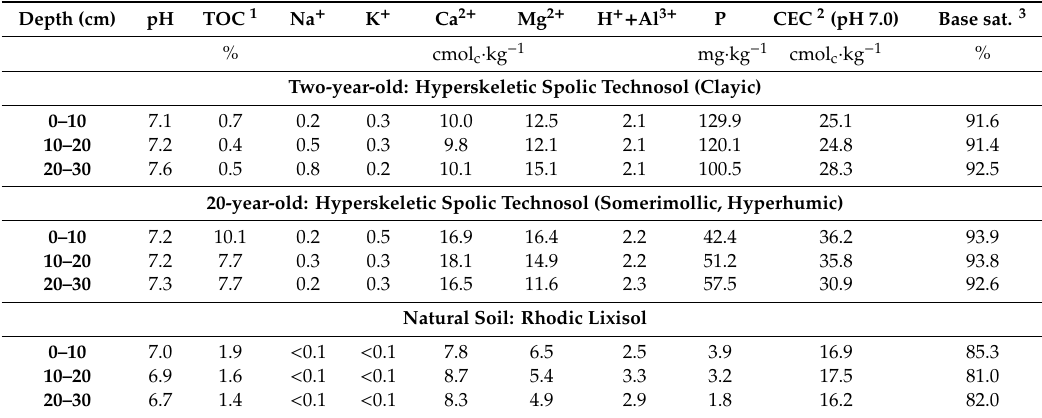
Table 1. Chemical attributes of topsoil of the studied Technosols and the natural soil. Depth